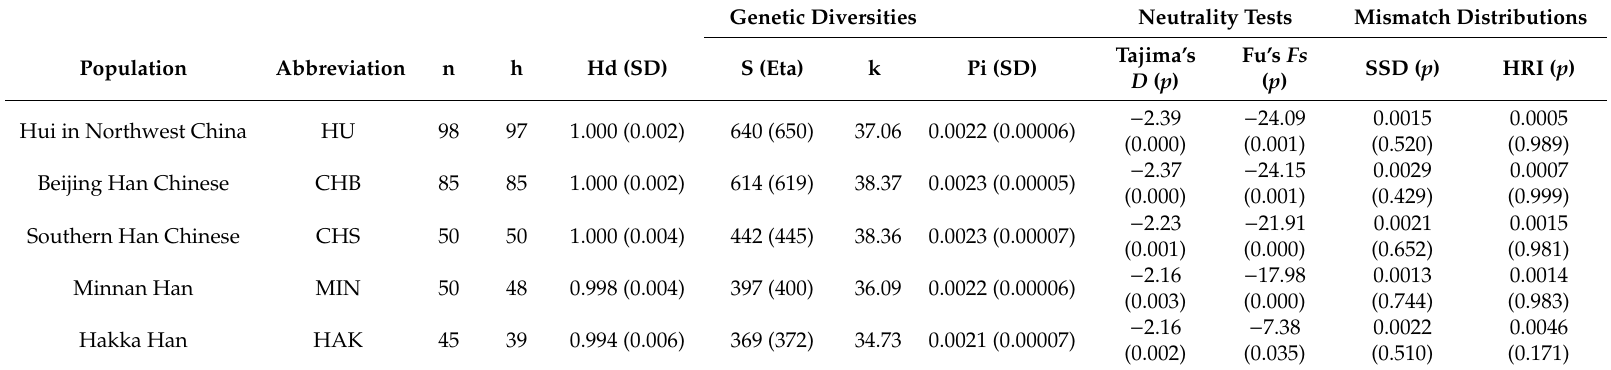
Table 1. Diversity indexes and neutrality tests for the studied Hui population and interested populations based on a complete mitogenome. Genetic Diversities